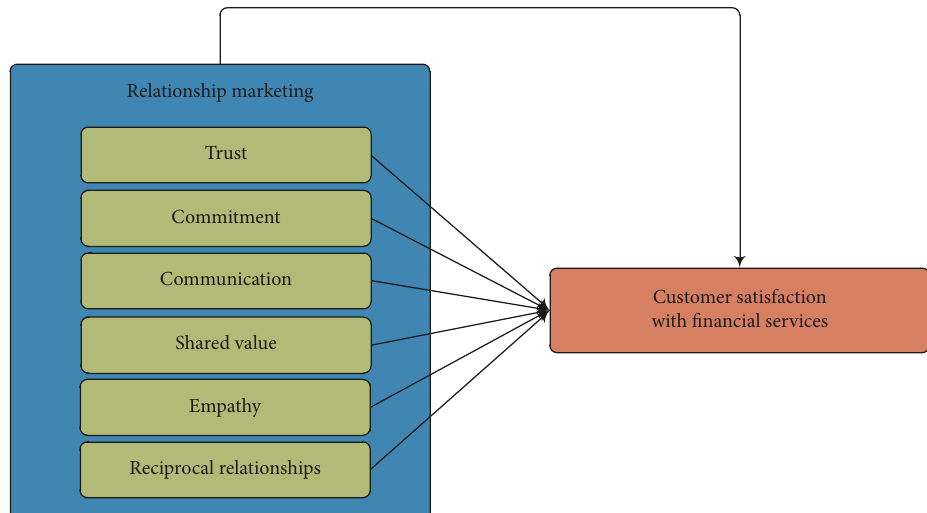
Figure 1: Conceptual model of the research.